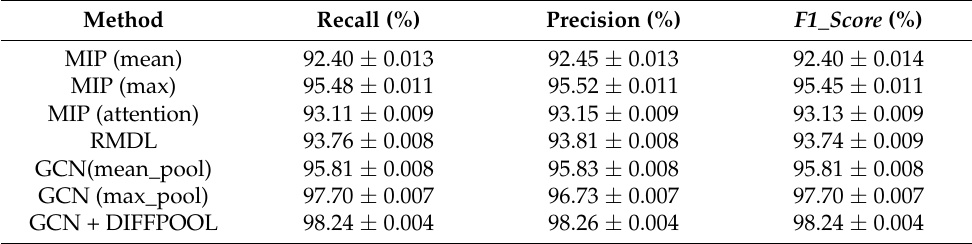
Table 4. Performance of different MIL methods on Mars